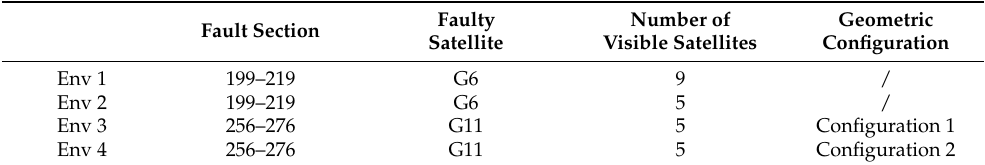
Table 3. Satellite observation environments.